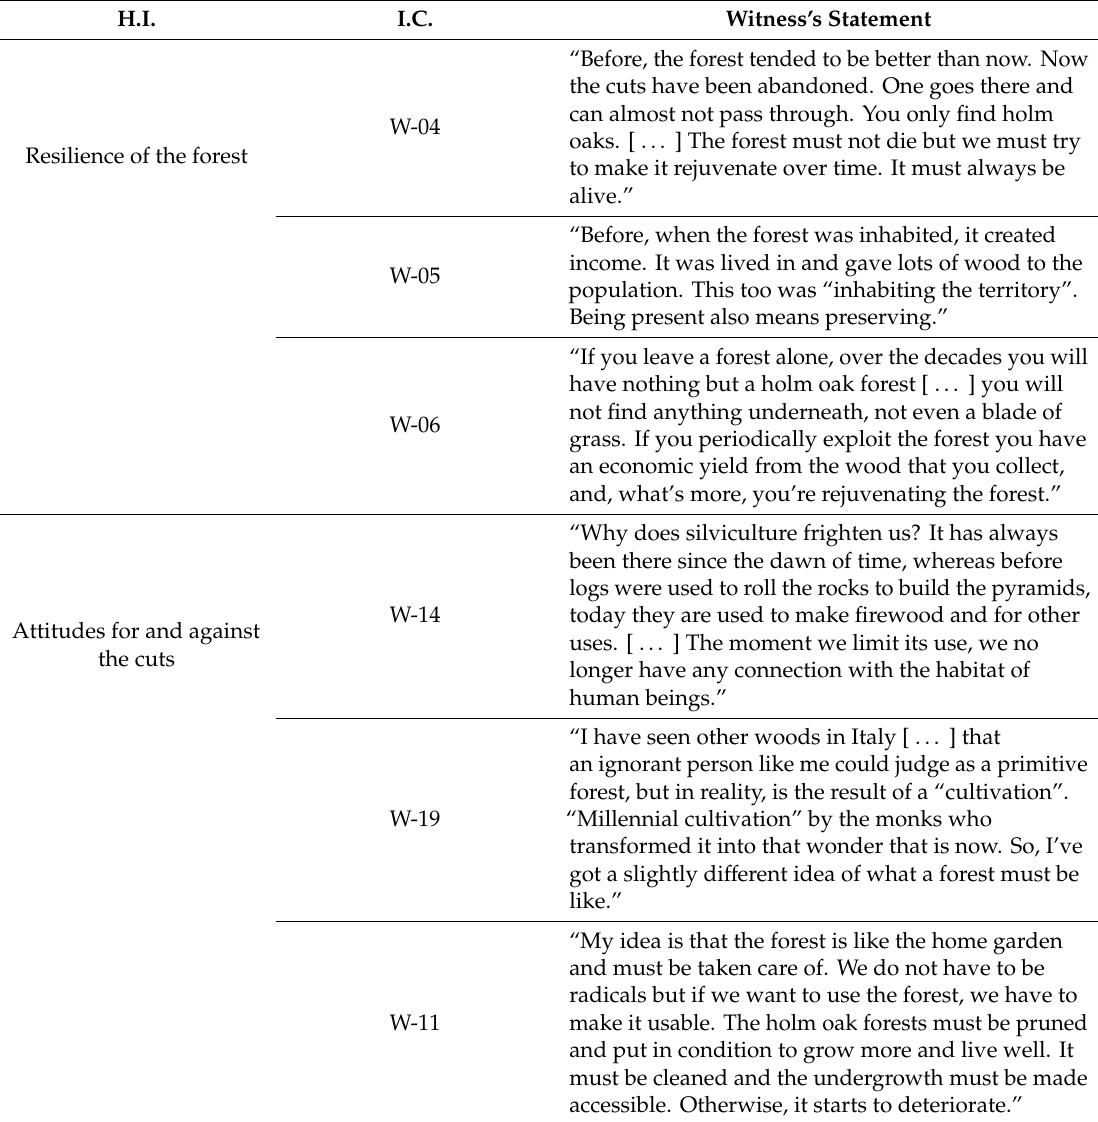
Table 5. Examples of homogeneous information (H.I.) about the socio-economic dimension of forestry.